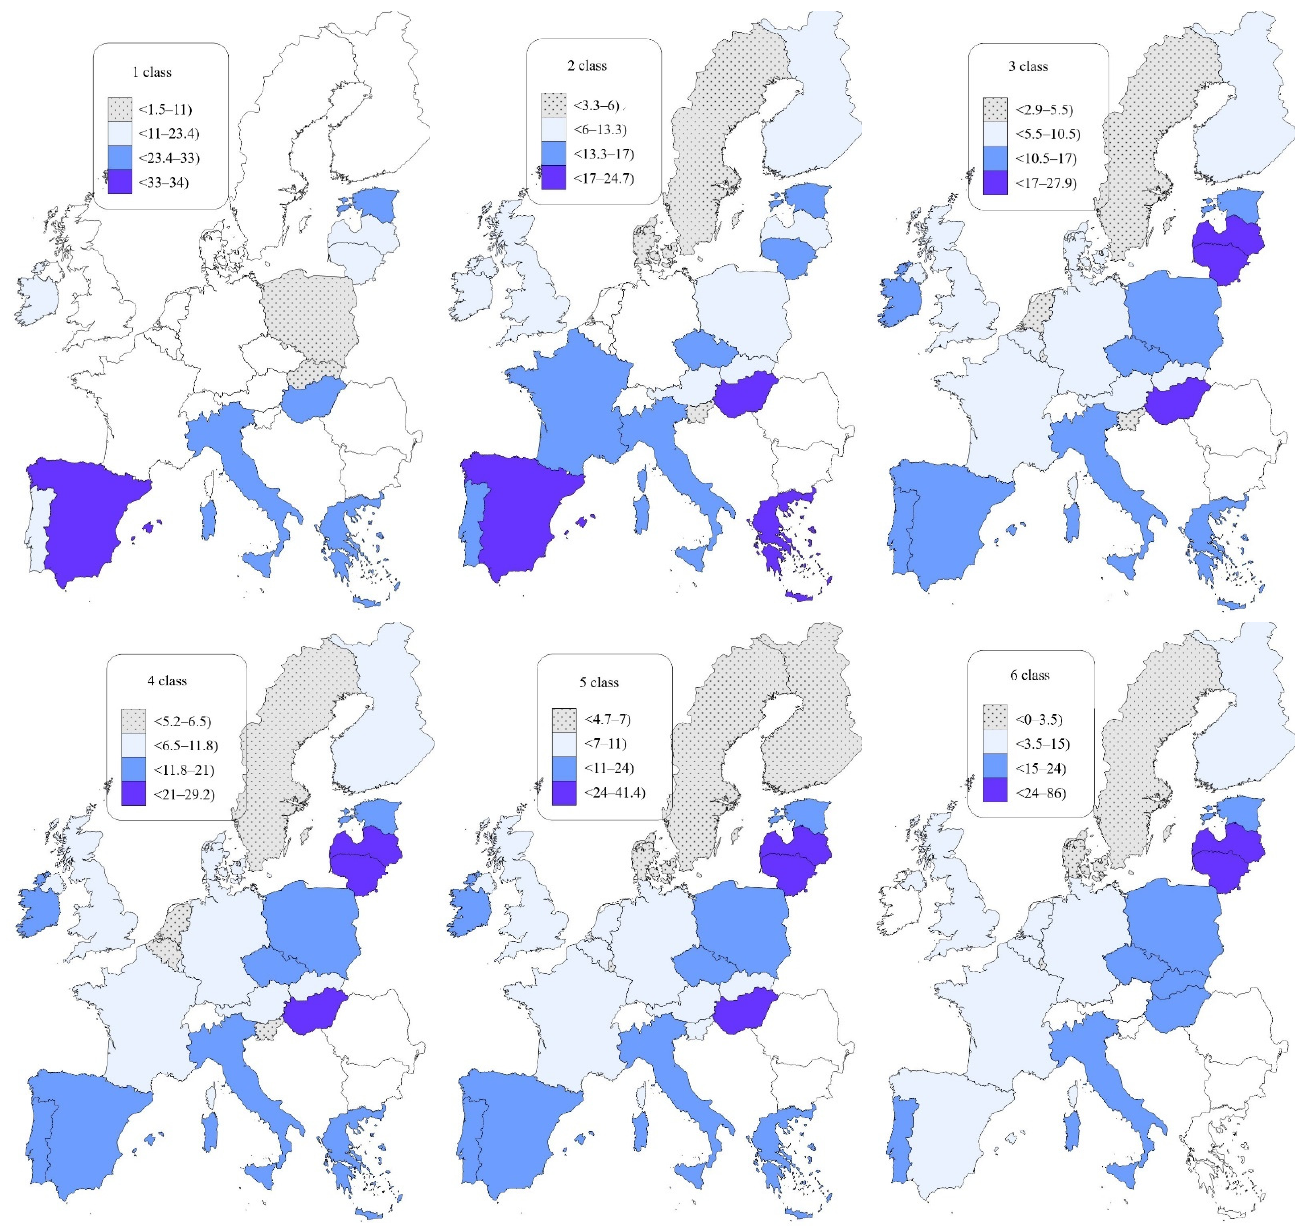
Figure 3. Relation of family farm income per full-time employee of the family in various farm production classes to non-farm income in EU countries (in%, average for 2004–2017); The white color of a country means that it was not possible to calculate the income relationship in that country because there was no such class of farms or because OECD statistics did not provide data on the average salary in that country. Source: own elaboration based on FADN and OECD [43] data .